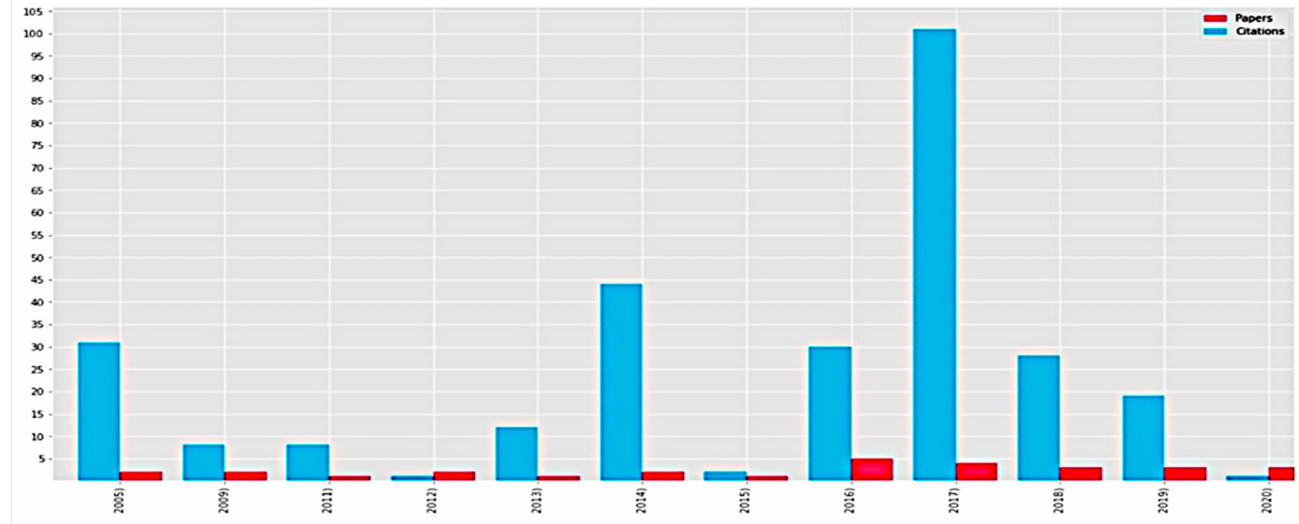
Figure 13. Publications’ statistical analysis of year